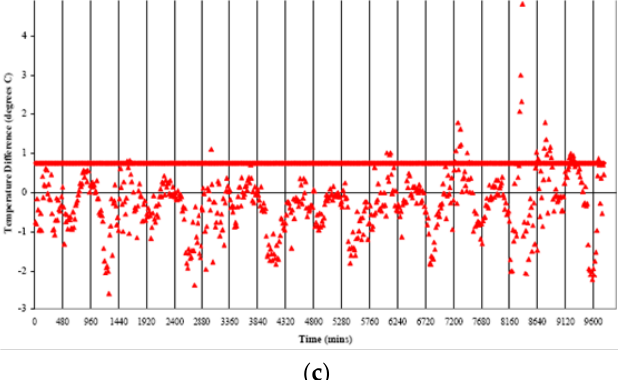
Figure 5. ( a ) Field trial of the system in a greenhouse; ( b ) a thermistor in contact with a strawberry leaf using a leaf clip; ( c ) temperature differences between a plant leaf and ambient air with a threshold of 0.84 °C to trigger water treatments.